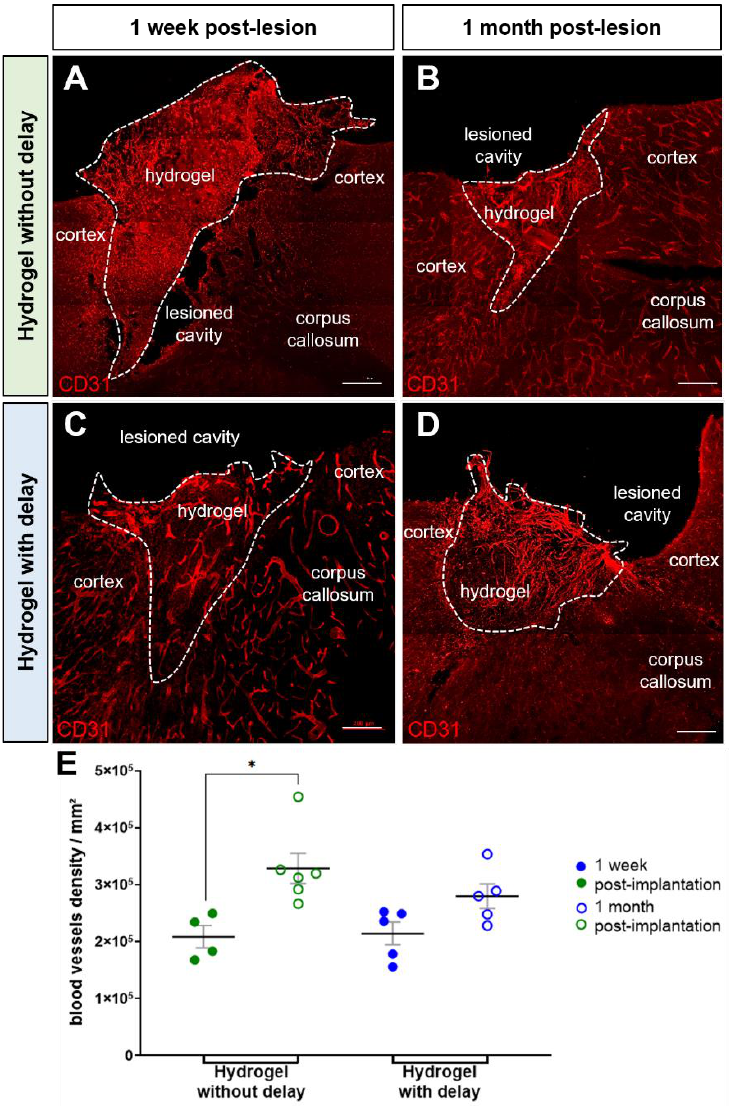
Figure 3. Hydrogel vascularization. ( A – D ) Representative immunofluorescence staining of blood vessels labeled with CD31 (red) in implanted mice in the no-delay group ( A , B ) or in delay group ( C , D ). Dashed lines indicate hydrogel localization. Scale bar: 200 μm. ( E ) Quantitative analysis of the blood vessels density over time in implanted mice in no-delay (green) or delay groups (blue). Two-way ANOVA * p < 0.05.